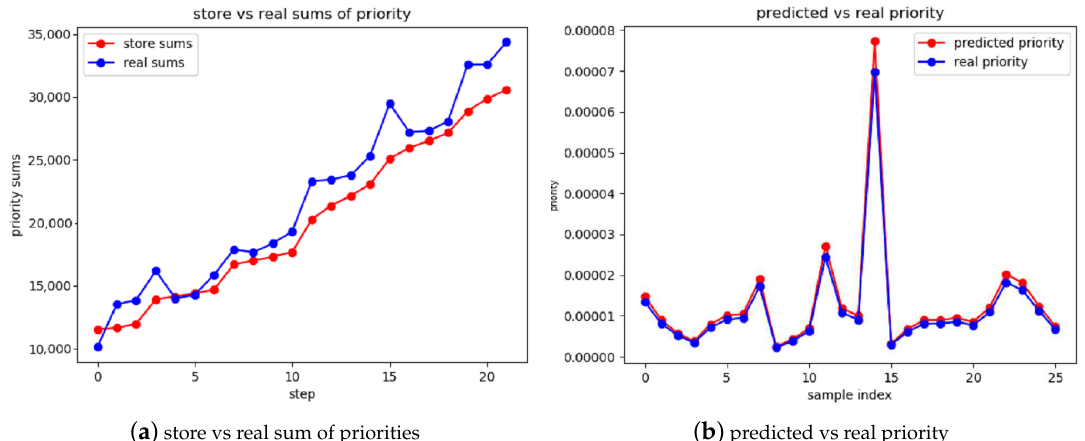
Figure 4. Using a simple linear model to predict the sum of real priorities. Based on the predicted value, we can estimate the real priority of each